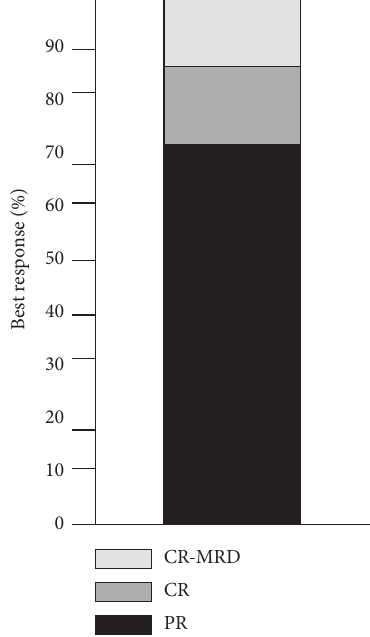
Figure 3: Best response achieved.